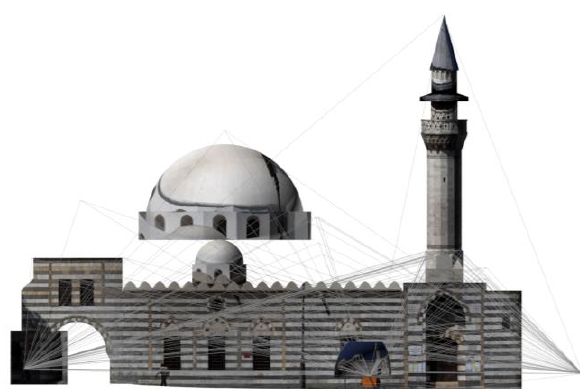
Figure 7 – al Darwikiya Mosque (plot and photomadeling by